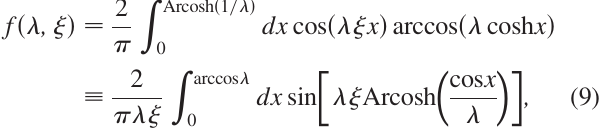
ffiffiffiffiffiffiffiffiffiffiffiffiffiffi p Þ . Shownin z 2 (cid:3) 1